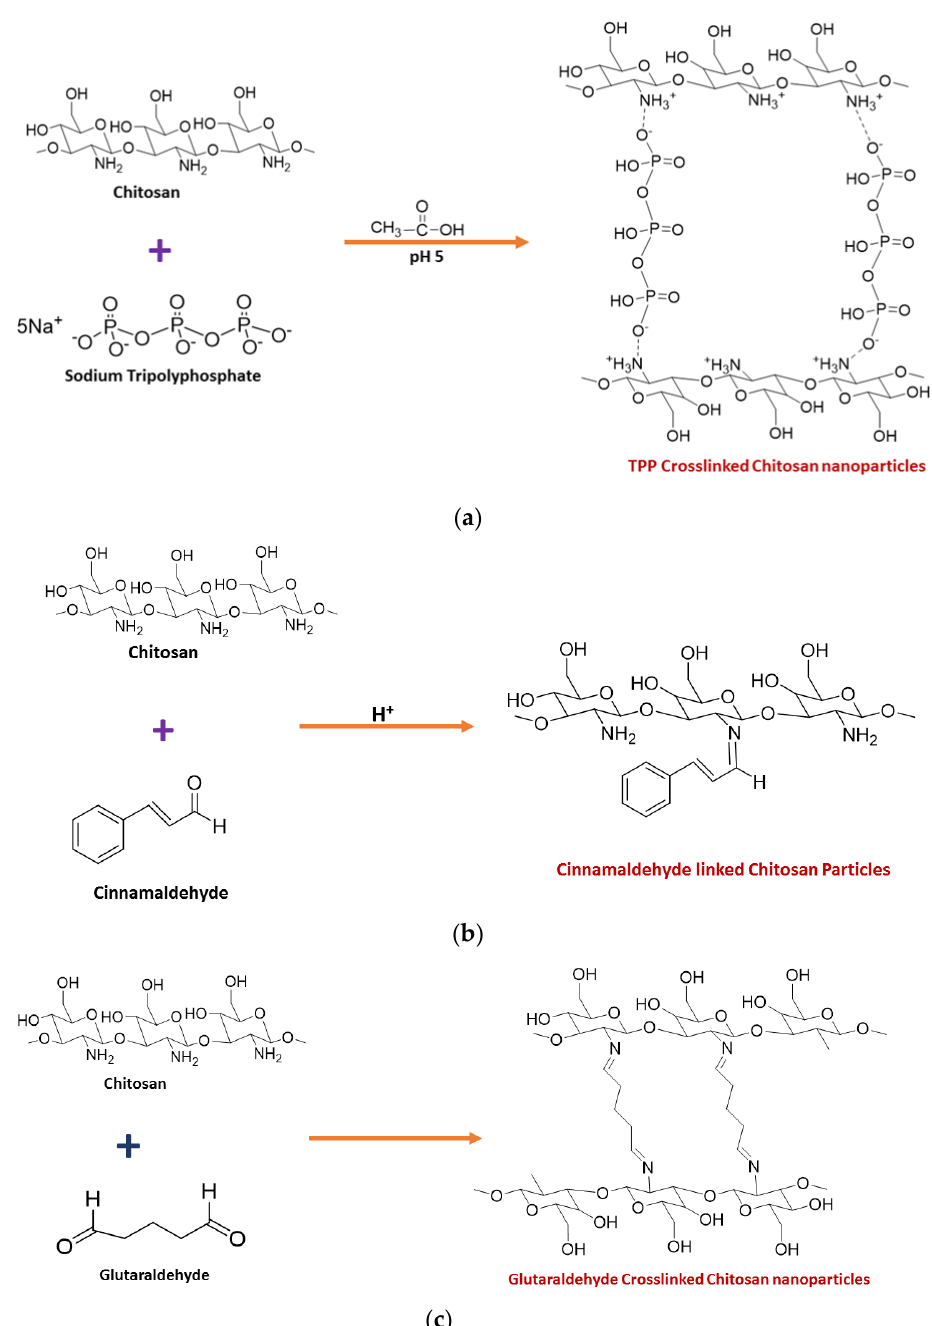
Figure 1. Synthesis of chitosan nanoparticles using ( a ) TPP ( b ) cinnamaldehyde ( c ) Glutaraldehyde as the crosslinker.